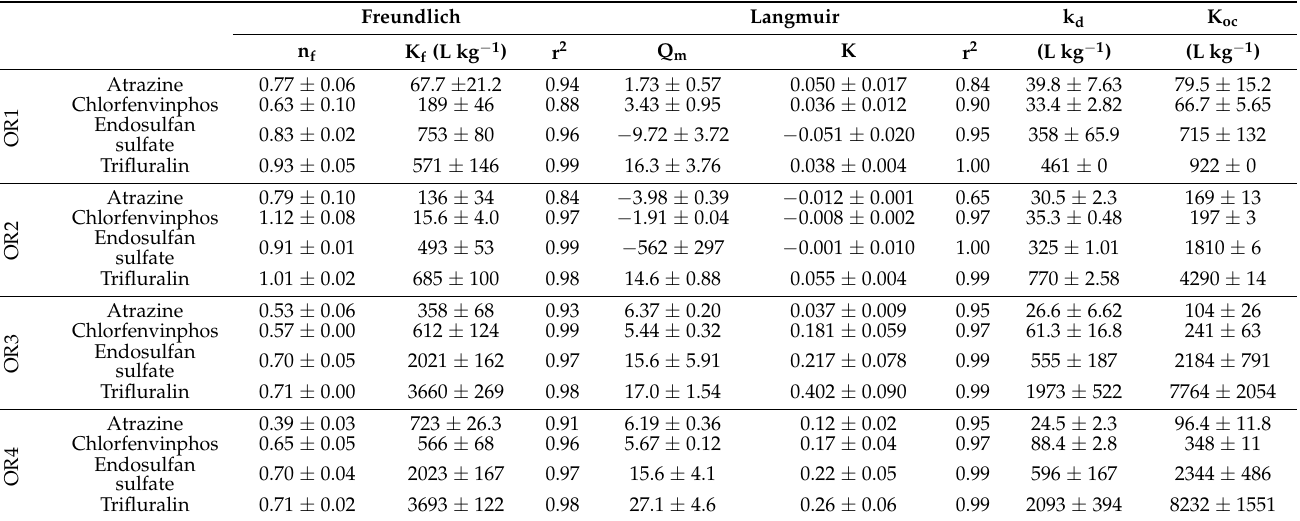
Table 3. Freundlich and Langmuir parameters obtained for different adsorbents. (OR1 = sawdust, OR2 = chicken manure, OR3 = orujillo, OR4 = composted urban solid